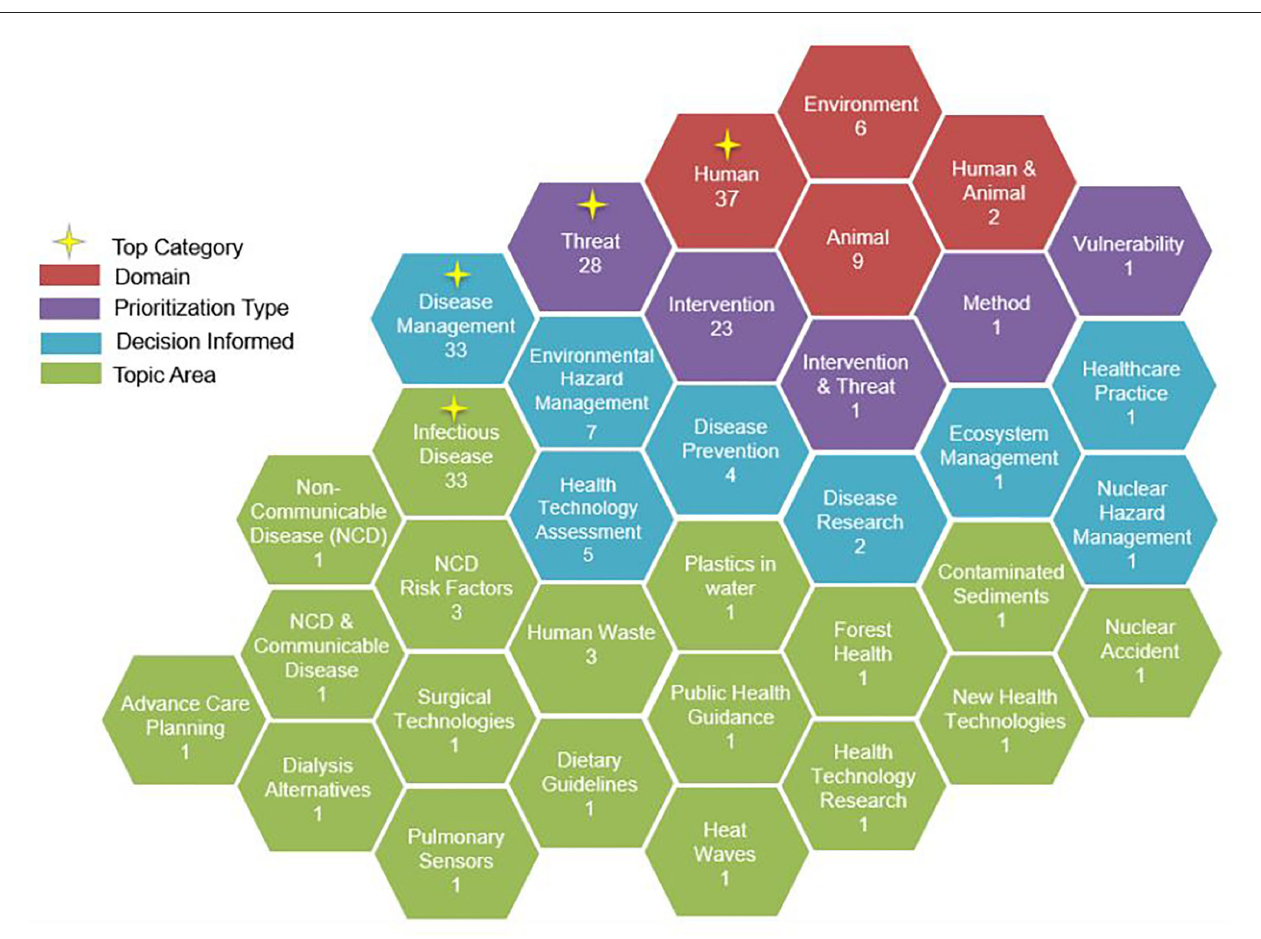
FIGURE 3 | Overview of study contexts by domain, decisions informed, prioritization type, and topic